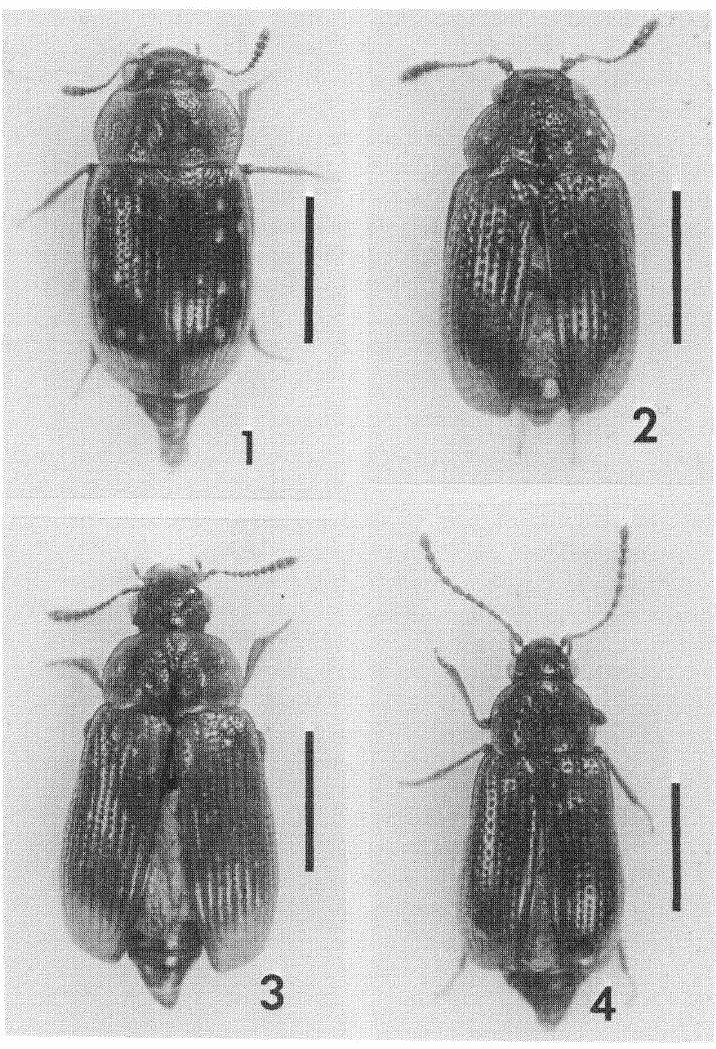
Figs. 1-4. Glypholoma spp. 1. G. pustuliferum. 2. G. pecki, holotype. 3. G. temporale, holotype. 4. G. tenicorne, holotype. Scale lines 1.0